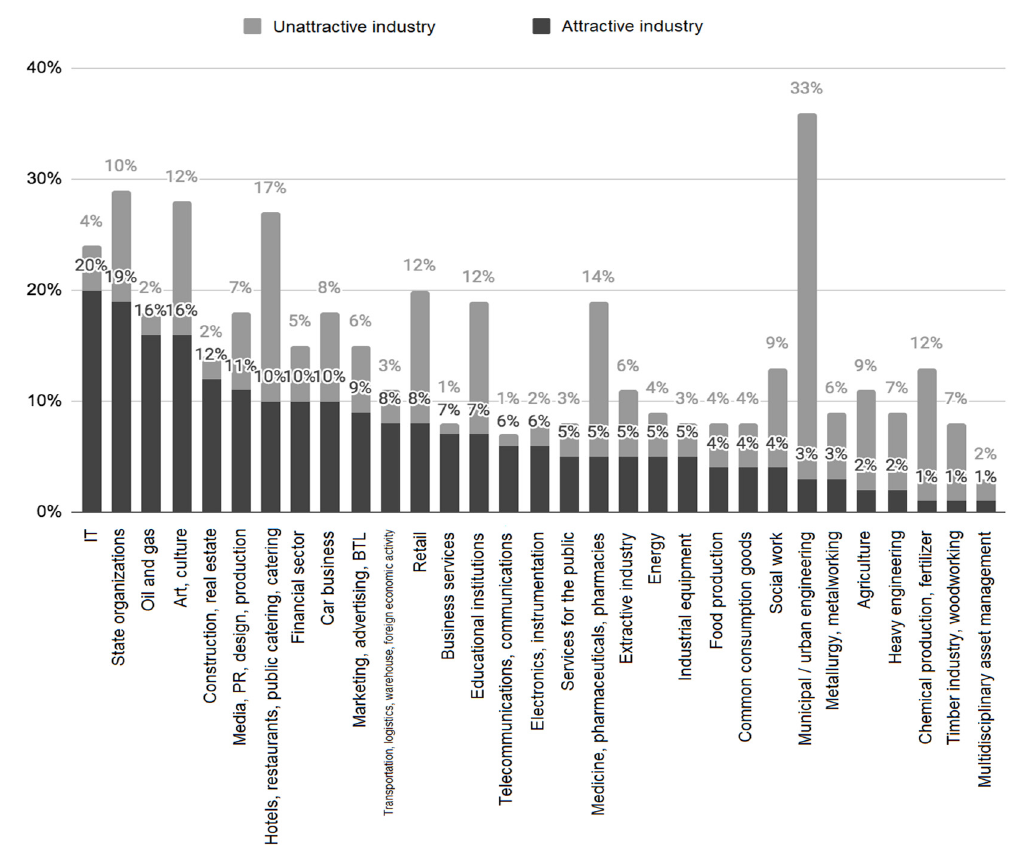
Figure 4. Distribution of industries according to their attractiveness among applicants (Compiled by the authors based on materials of Almanac HeadHunter (2017)).